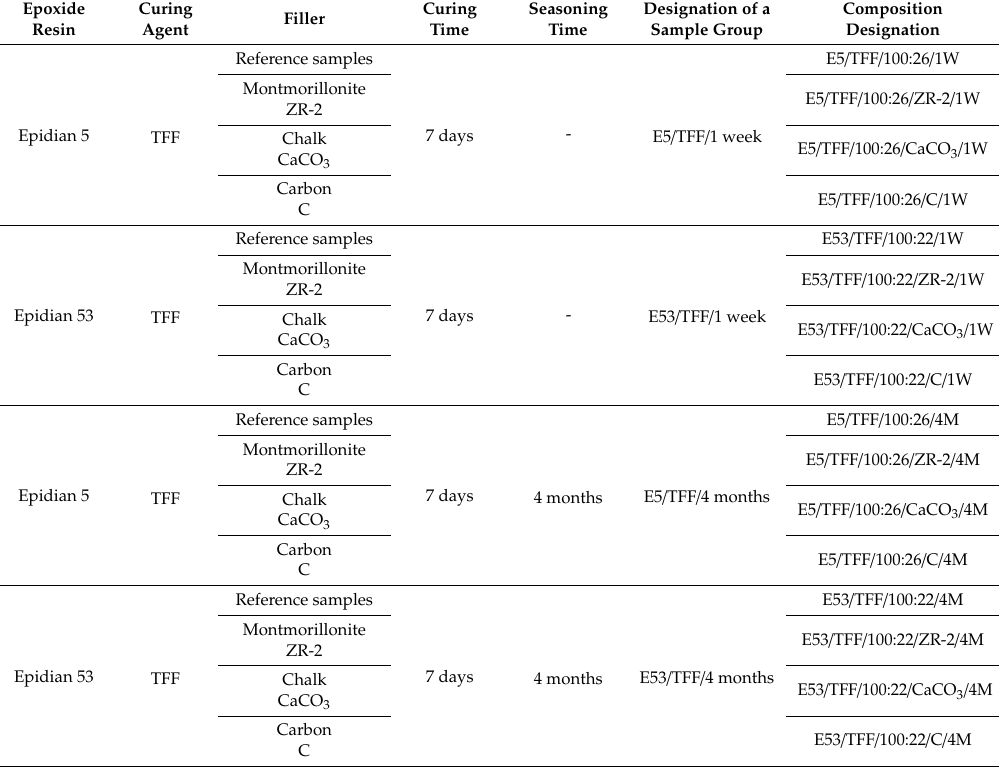
Table 4. Types of adhesive compositions, seasoning time, and composition